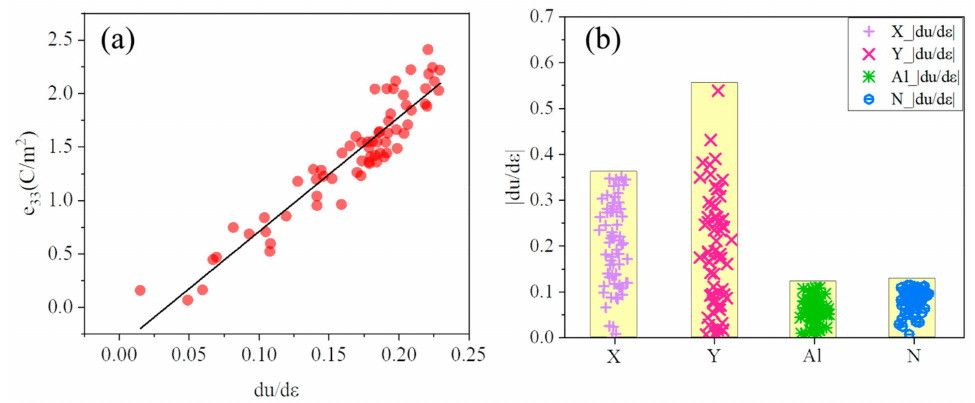
Figure 3. ( a )The relationship of the e 33 and du/d ε . du/d ε is measured by calculating the response of the u ( n ) under a macroscopic strain ( η = 0.5%). The result of the linear fitting is shown as a solid line. ( b )The | du/d ε | of X, Y, Al, and N in X 0.125 Y 0.125 Al 0.75 N